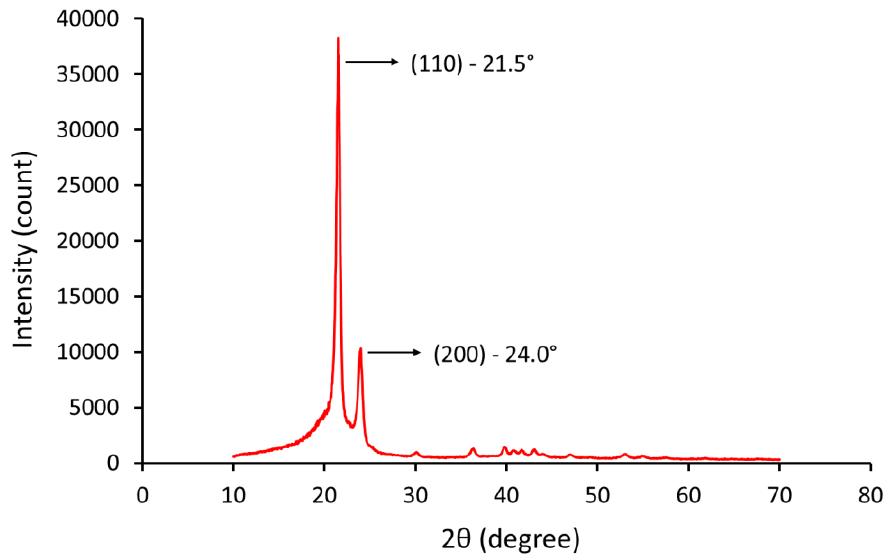
Figure 9. X-ray di ff raction pattern of UHMWPE powder. Figure 9. X-ray diffraction pattern of UHMWPE powder.